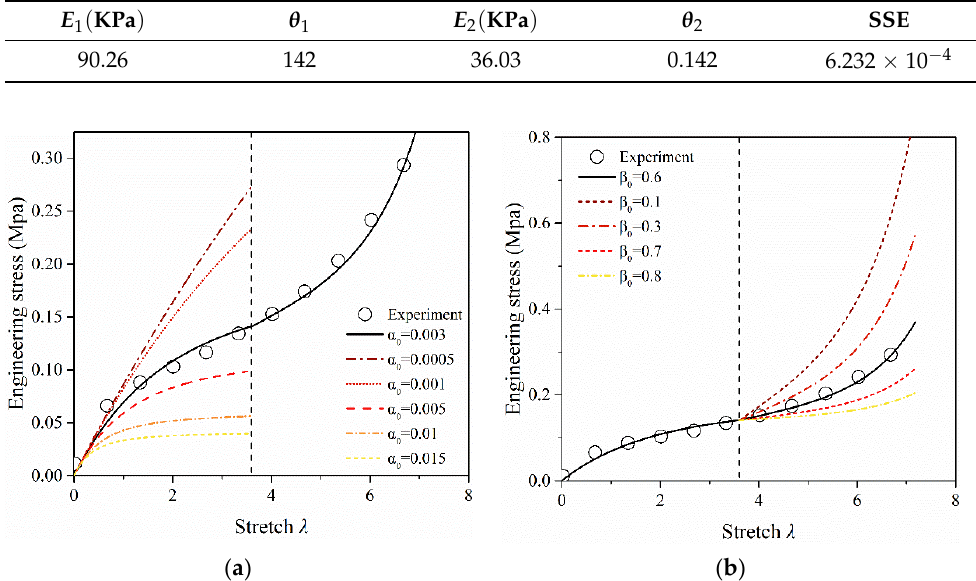
Figure 4. The derived evolution of variable order. Table 2. Derived material parameters and error values of soft elastomer at stretch rate 0.065/s.